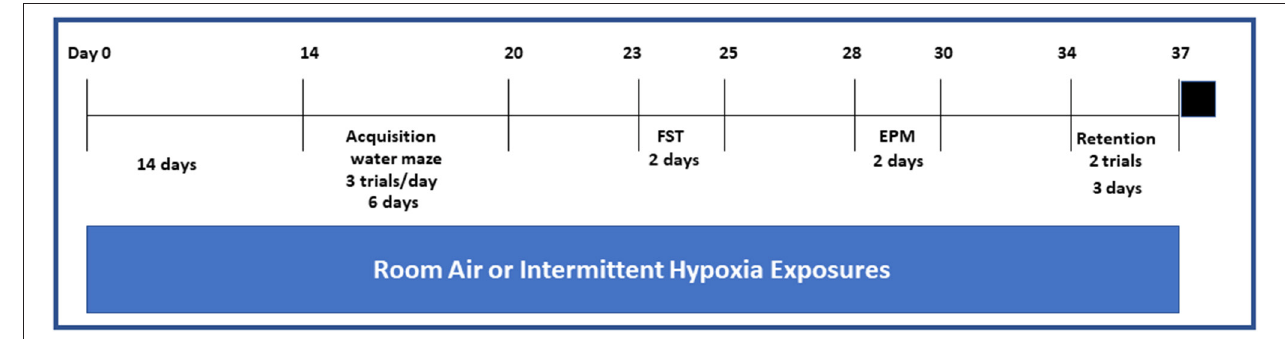
FIGURE 1 | Schematic diagram on the sequence of exposures to either IH or RA and behavioral experiments and in both wild type and Ngb TG mice. Black square on the far end right of the figure indicates euthanasia. Please note that exposures to either IH or RA were continued throughout the duration of the protocol.